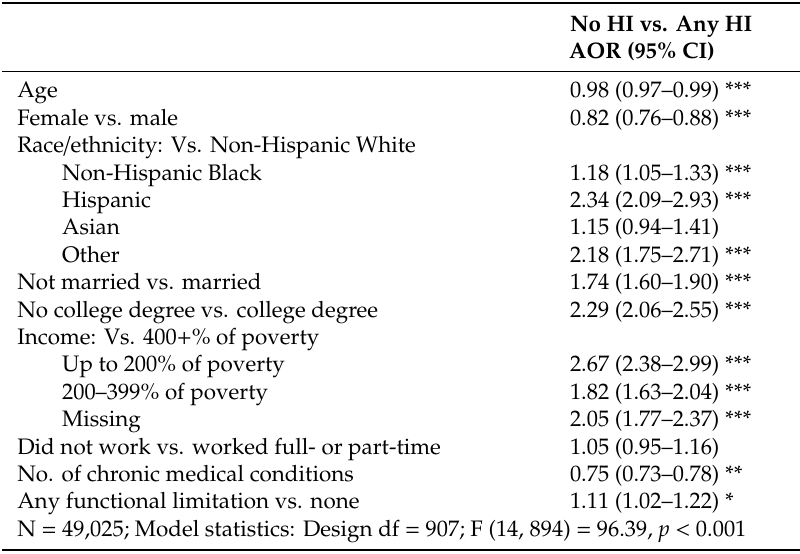
Table 4. Sociodemographic and health correlates of no health insurance (HI) among the 50–64 age group.